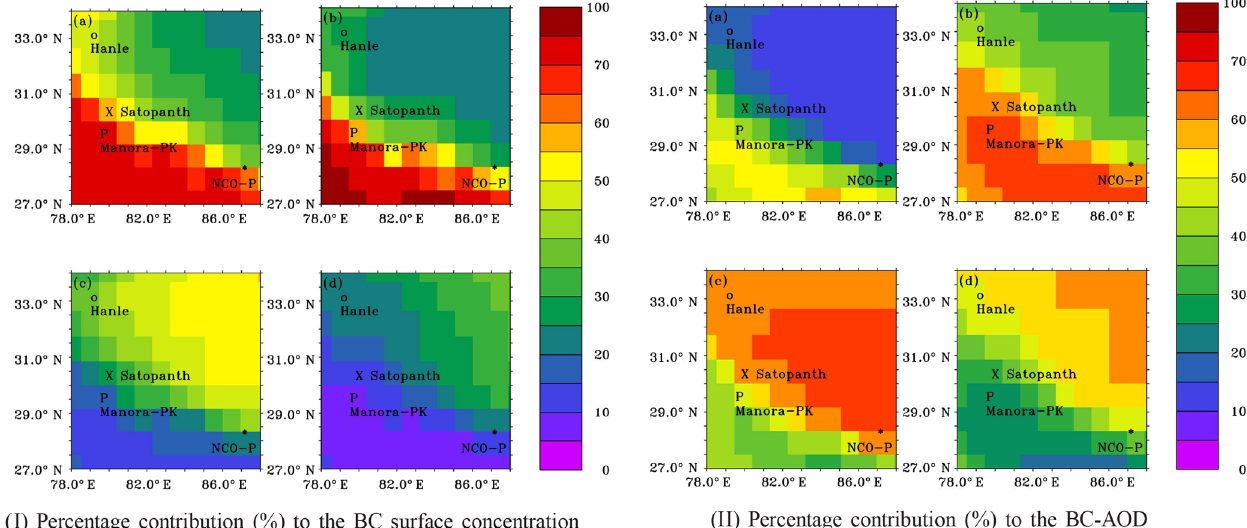
Figure 4. Spatial distribution of mean of (I) surface BC concentration and (II) BC-AOD for winter (a, c) and pre-monsoon (b, d) due to relative percentage contribution (%) of emissions from the IGP (a, b) and AFWA (c, d) .